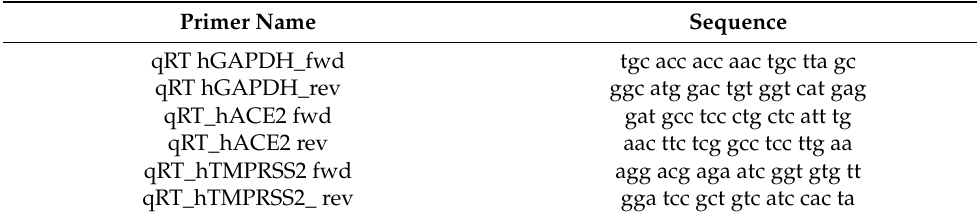
Table 1. Primer sequences used for quantitative real-time